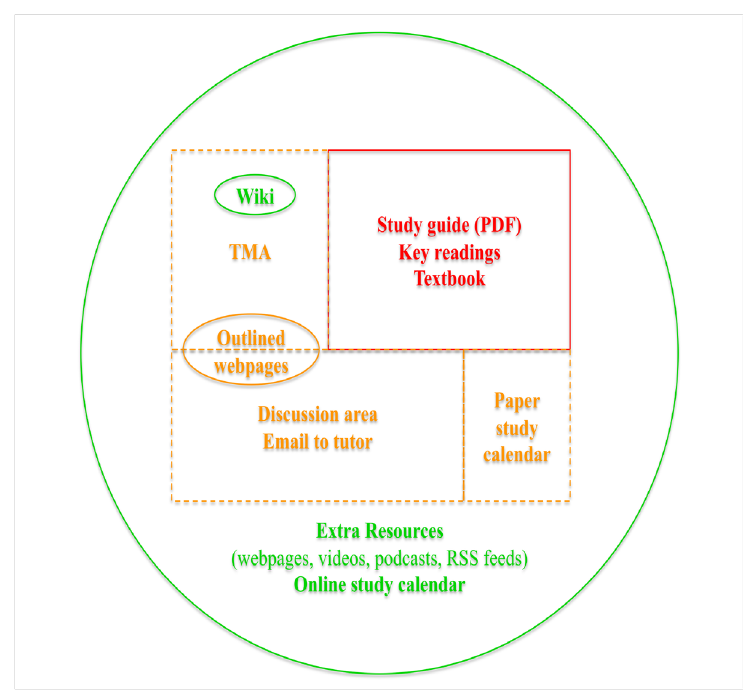
Figure 1 . Teaching tools supplied to students and toolbox (red – examinable resources; orange –optional resources but strongly recommended; green – purely optional resources).